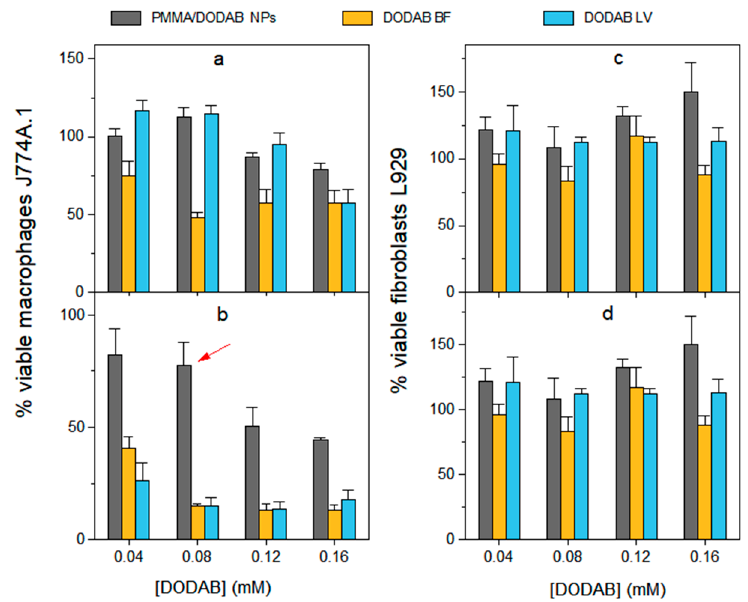
Figure 3. Cell viability of macrophages (J774A.1) or fibroblasts (L929) as affected by three different adjuvants containing dioctadecyl dimethyl ammonium bromide (DODAB) at 3 ( a , c ) and 24 h interaction time ( b , d ). The adjuvants were DODAB bilayer fragments (DODAB BF) (in yellow), DODAB bilayer vesicles (DODAB LV) (in blue) and poly (methyl methacrylate) (PMMA)/DODAB hybrid NPs (in gray). The DODAB concentration used for the three different adjuvants (PMMA/DODAB NPs, DODAB BF and DODAB LV) was indicated by the red arrow and corresponded to 0.08 mM DODAB.